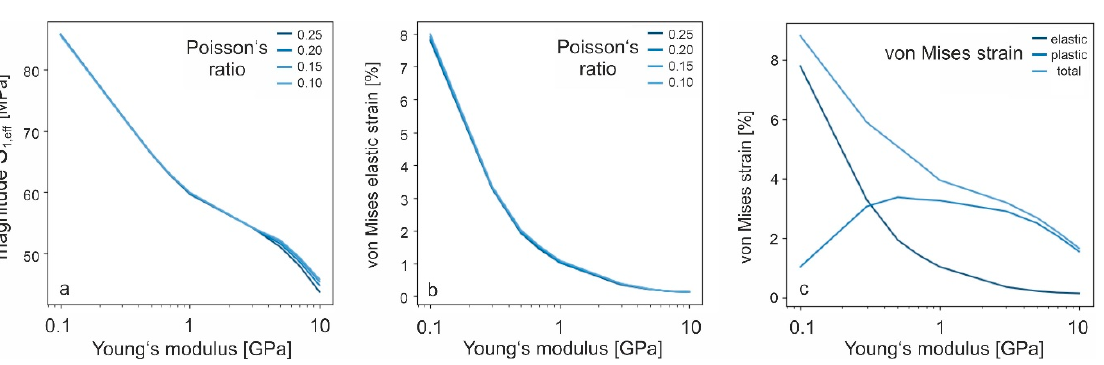
Figure 12. Maximum values of the ( a ) magnitude of the effective maximum principal stress (S 1,eff ), and ( b ) the von Mises elastic strain for different Young’s moduli and Poisson’s ratios assigned to the fault zone. ( c ) Comparison of von Mises elastic, plastic and total strain after five years of injection for different Young’s moduli and a Poisson’s ratio of 0.25.